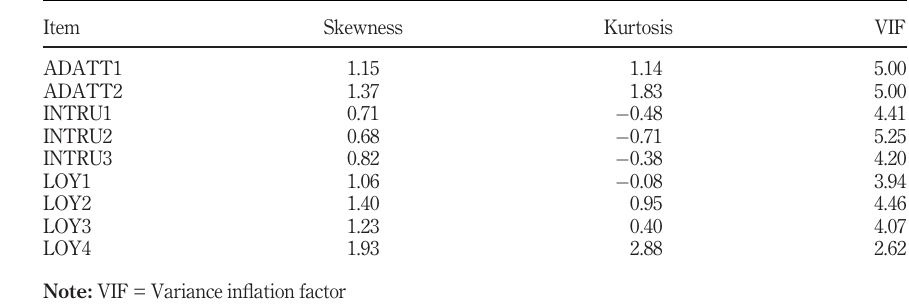
Table III. Normality and multicollinearity tests: skewness, kurtosis and